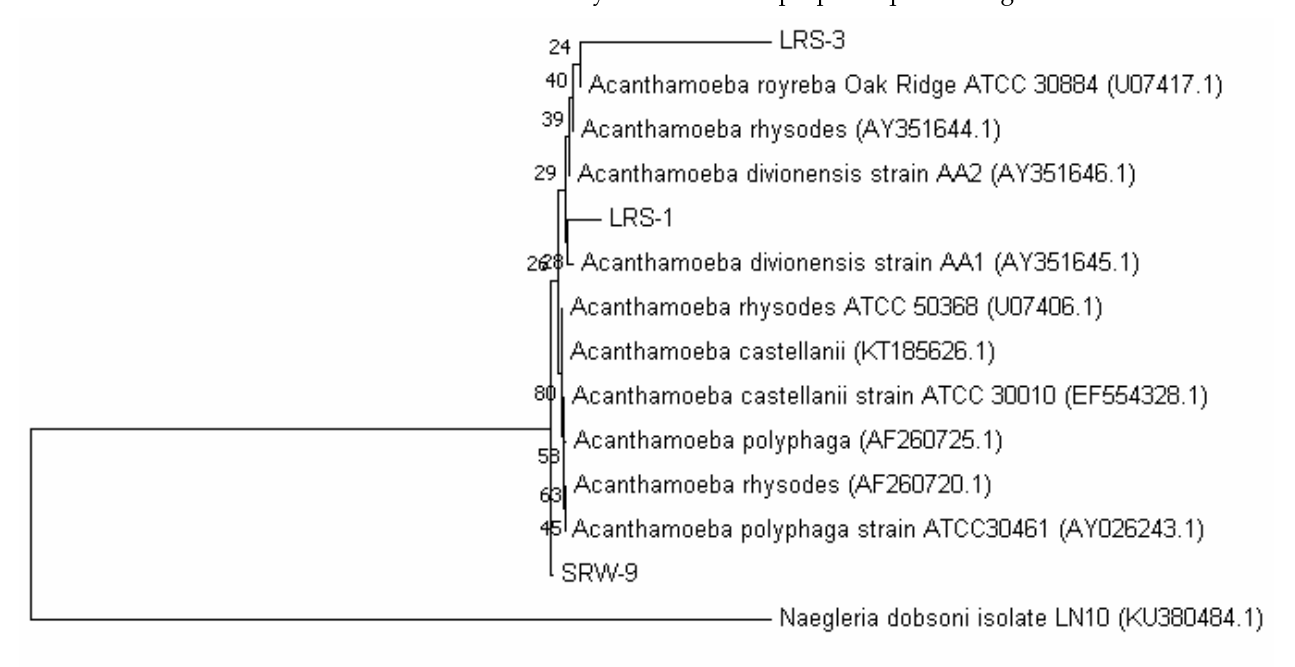
Figure 3. Phylogenetic analysis of Atacama Acanthamoeba spp. 18S rRNA gene sequences by the neighbor-joining method. Evolutionary analyses were done with MEGA7, and horizontal bars represent 0.50 substitutions per nucleotide site. The percentage of trees for associated taxa is shown at the branches with a bootstrap of 1000.